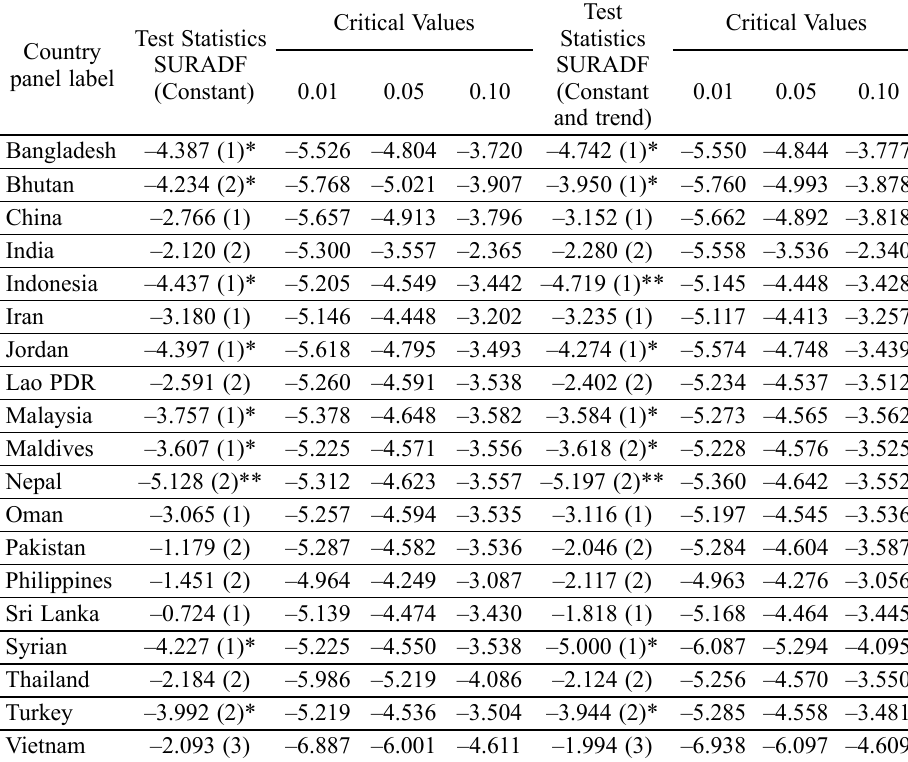
Table 2. SURADF estimation and the critical values